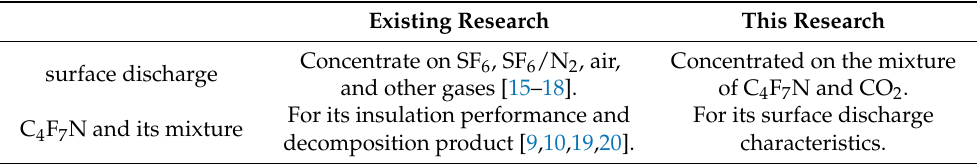
Table 1. Comparison between existing research and this research. Existing Research This Research Concentrate on SF 6 , SF 6 /N 2 , air, Concentrated on the mixture surface discharge and other gases [15–18]. of C 4 F 7 N and CO 2 . For its insulation performance and For its surface discharge C 4 F 7 N and its mixture decomposition product [9,10,19,20].